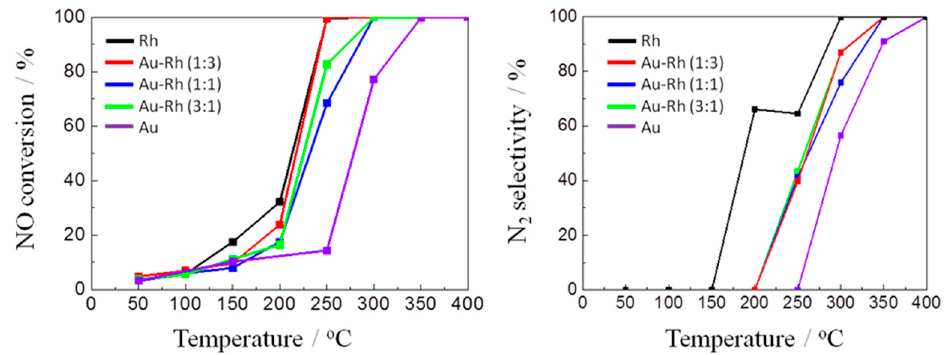
Table 1. BET, STEM and X-ray photoelectron spectroscopy (XPS) analyses of Au/Al 2 O 3 , Rh/Al 2 O 3 , and AuRh/Al 2 O 3 catalysts with specified molar ratios of Au:Rh.